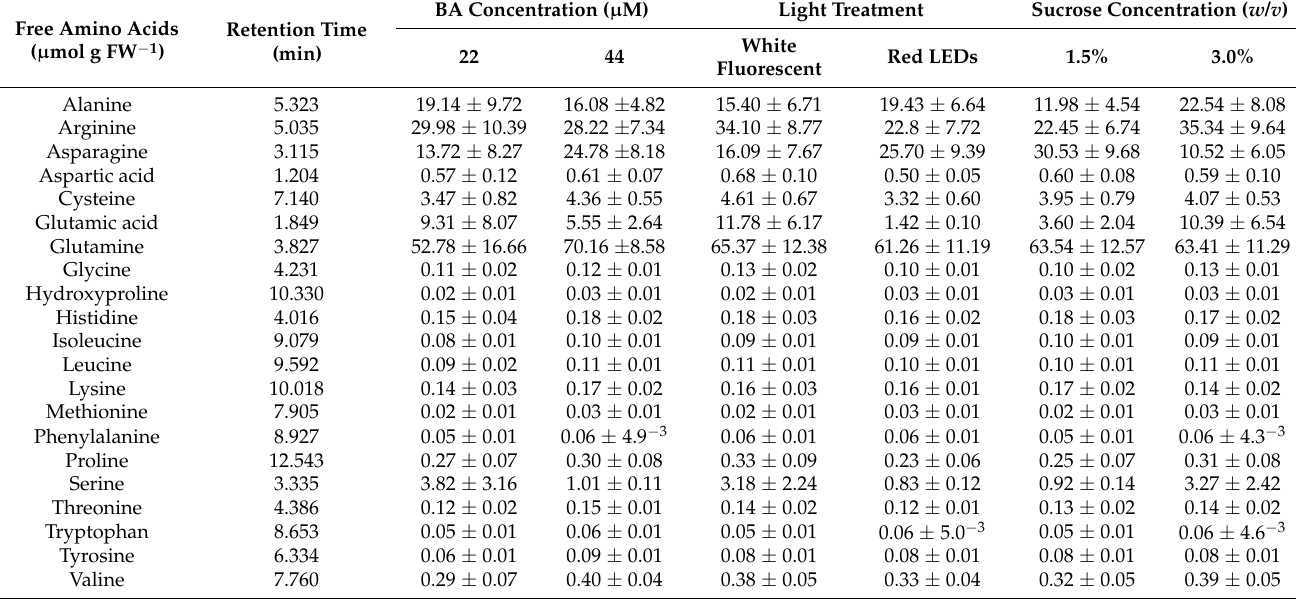
Table 3. Effect of 6-Benzyladenine (BA) (22 and 44 µ M) and sucrose concentration (1.5 and 3.0% ( w / v )) and light treatment (white fluorescent or red LEDs) on amino acid content ( µ mol g FW − 1 ) of Pinus radiata D. Don shoots cultured in rooting medium (Quoirin and Lepoivre (LP) medium [27], modified according to Aitken-Christie et al. [28], supplemented with mixture of 5 µ M 1-Naphthaleneacetic acid (NAA) and 10 µ M indole-3-butyric acid